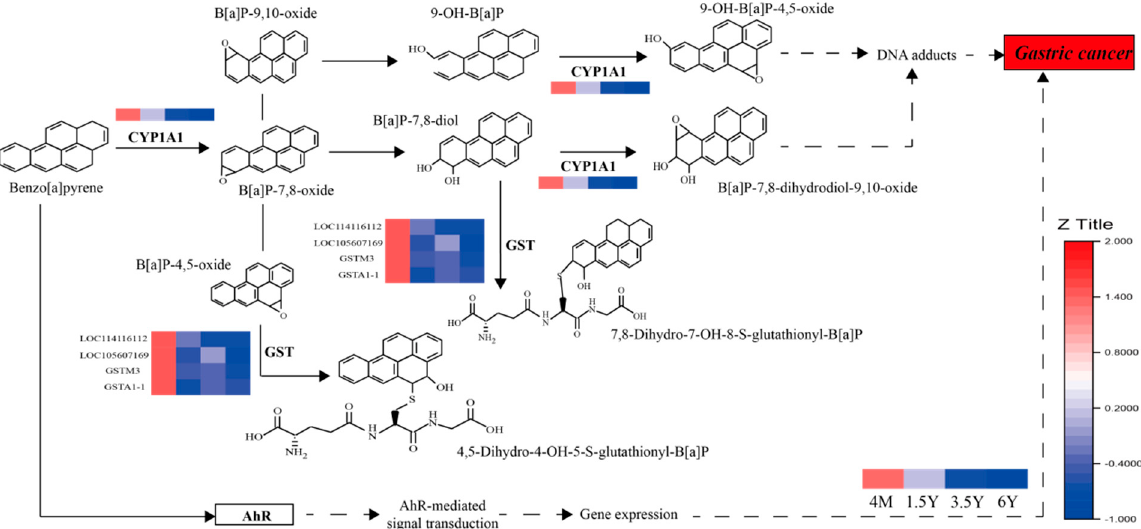
Figure 8. Immune-related pathways. Note: The heat map in the pathway represents gene expression at four ages and the redder the color, the higher the gene expression. CYP1A1: gene-CYP1A1 ; GST: gene-GSTA1-1, gene-GSTM3, LOC114116112, LOC105607169 ; AhR: aryl hydrocarbon receptor. 4M: 4 months; 1.5Y: 1.5 years; 3.5Y: 3.5 years; 6Y: 6 years.